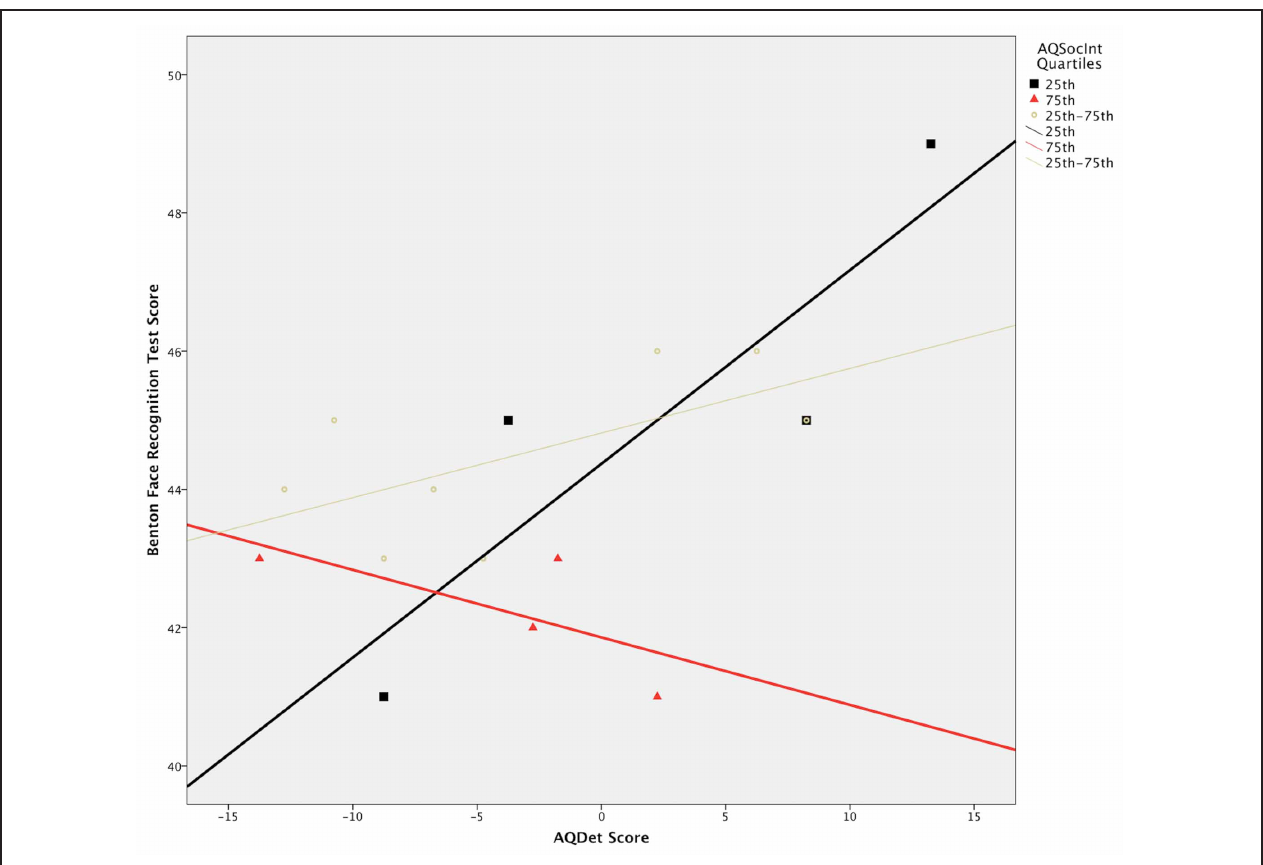
plots within the above Figure should, however, be interpreted in the context of the full number of 16 or 15 individuals per condition, as quartile distinctions were used solely for graphing purposes (i.e., to bring interaction effects into greater relief in the above Figure). Quantitative significance levels (tail probabilities) are provided in the